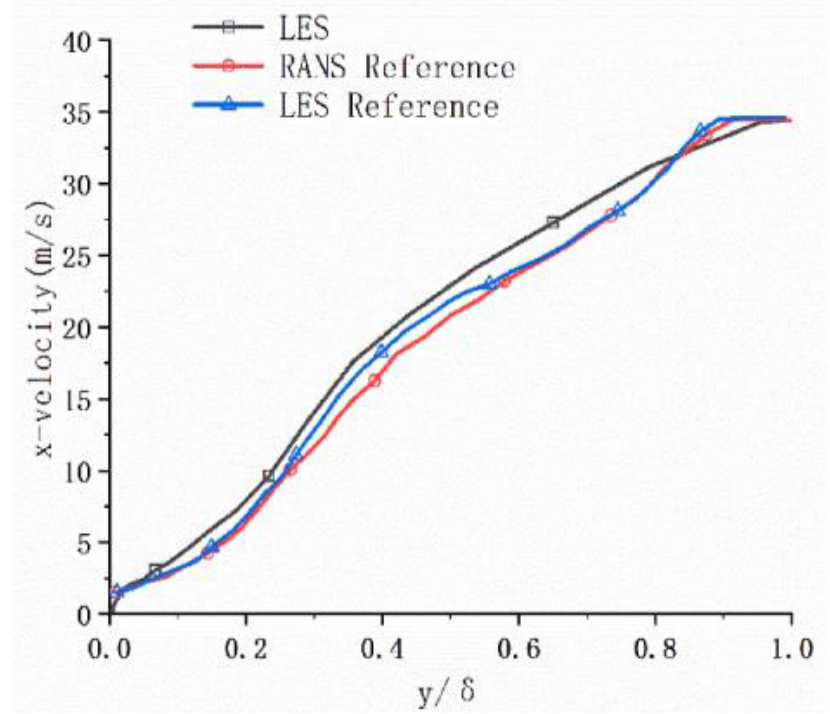
Figure 10. Velocity profile of smooth plate at 0.1 Ma.